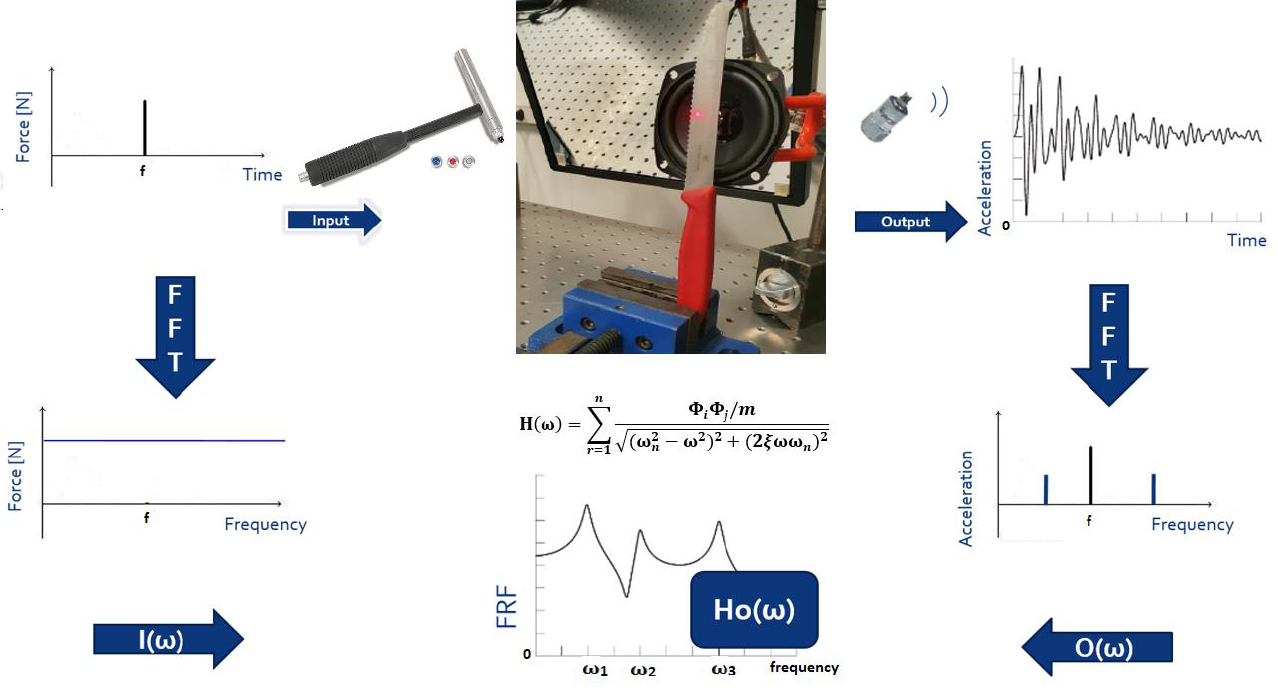
Figure 1. Modal analysis process schema.